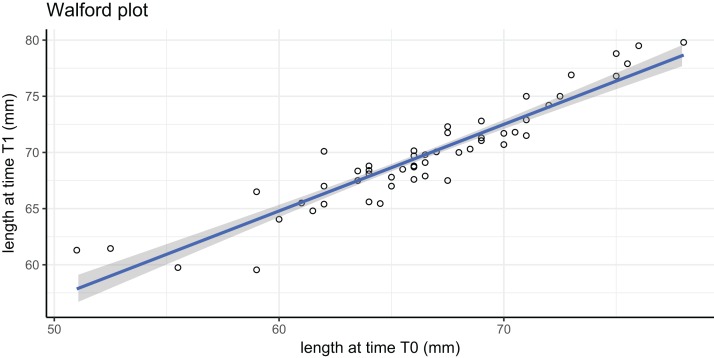
Walford plot regression equation.\documentclass[12pt]{minimal}
\usepackage{amsmath}
\usepackage{wasysym}
\usepackage{amsfonts}
\usepackage{amssymb}
\usepackage{amsbsy}
\usepackage{upgreek}
\usepackage{mathrsfs}
\setlength{\oddsidemargin}{-69pt}
\begin{document}
}{}${L_{{t_1}}} = {L_{{t_0}}}*{\rm{0}}{\rm{.771}} + {\rm{18}}{\rm{.524}}$\end{document}Lt1=Lt0*0.771+18.524; R2 = 0.869. Gray area represents 95% confidence intervals.